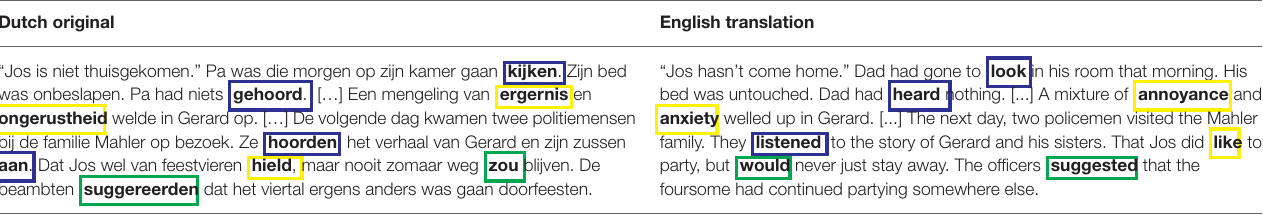
TABLE 1 | A coded excerpt from the stimulus narrative. Dutch original English